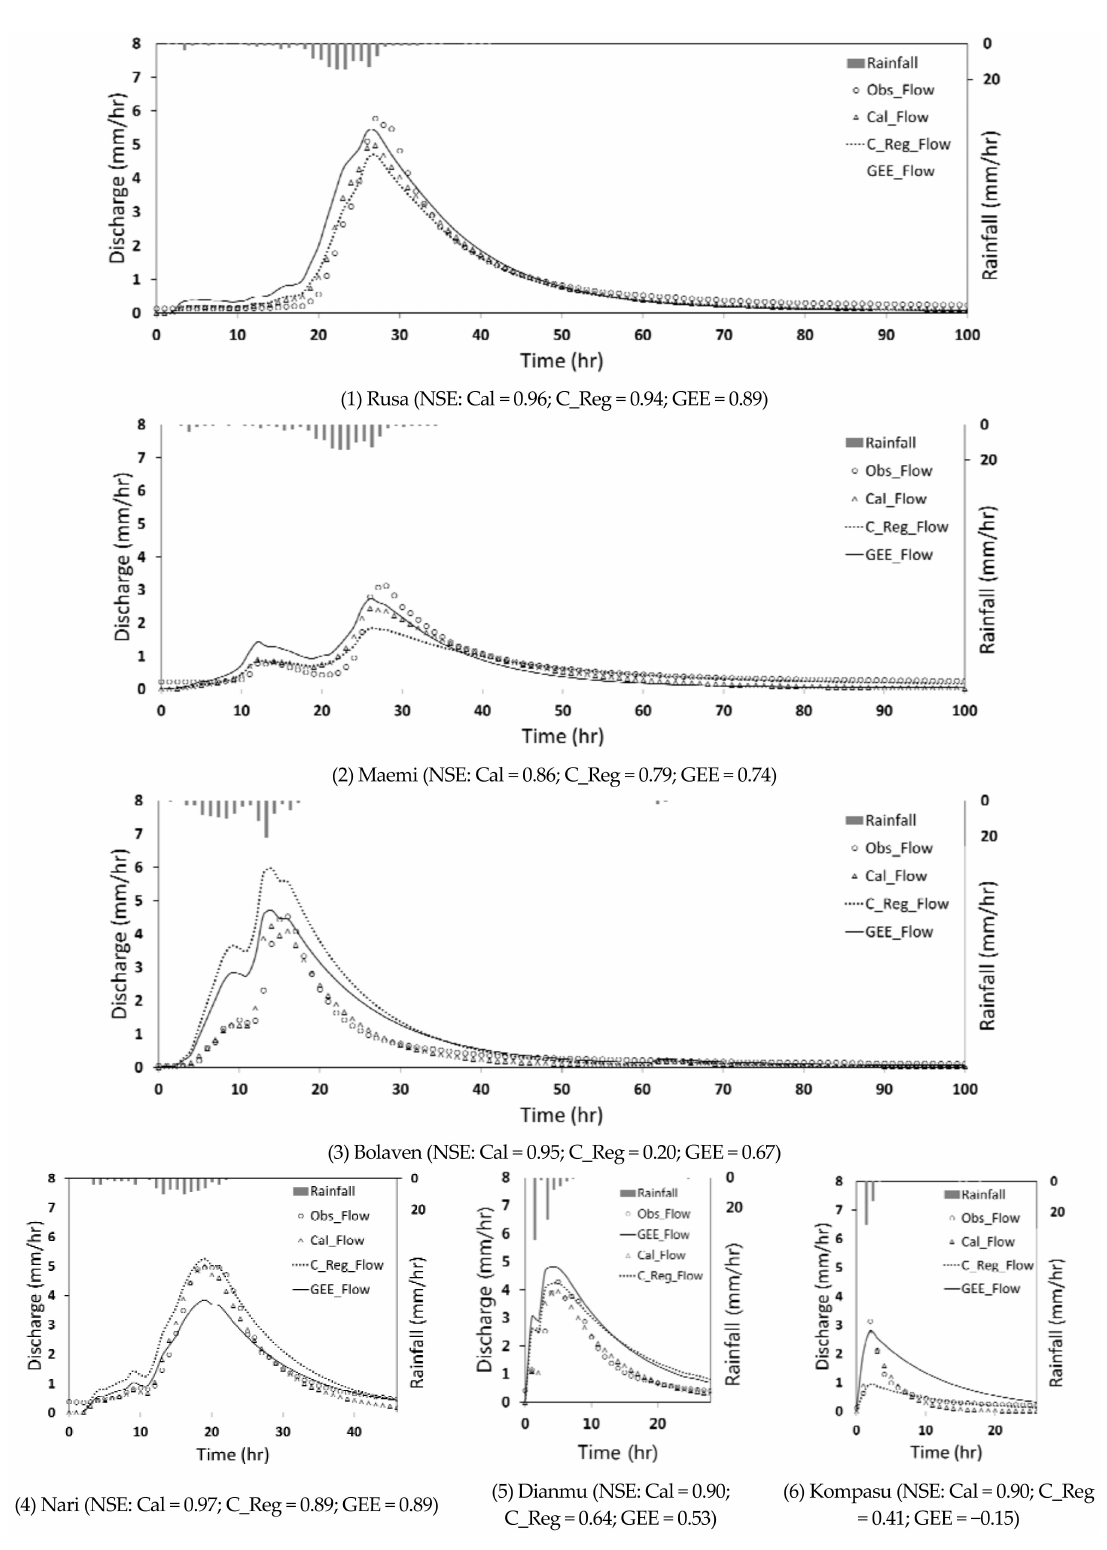
Figure 7. Modelled and observed hydrographs at catchment